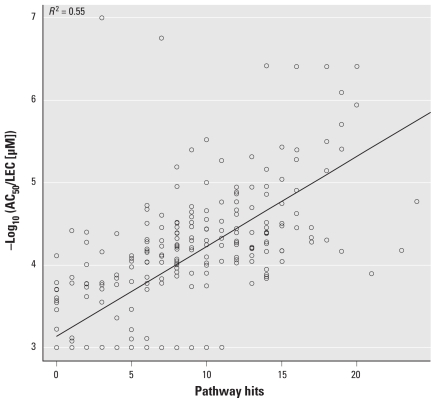
Plot of the minimum concentration at which a chemical caused cytotoxicity as a function of the number of minimal pathways in which the chemical was active at concentrations < 30 μM. Chemicals for which no cytotoxicity was observed were assigned an AC50 of 1 mM. The correlation coefficient is minimally sensitive to this default value. The line gives the fitted regression model.